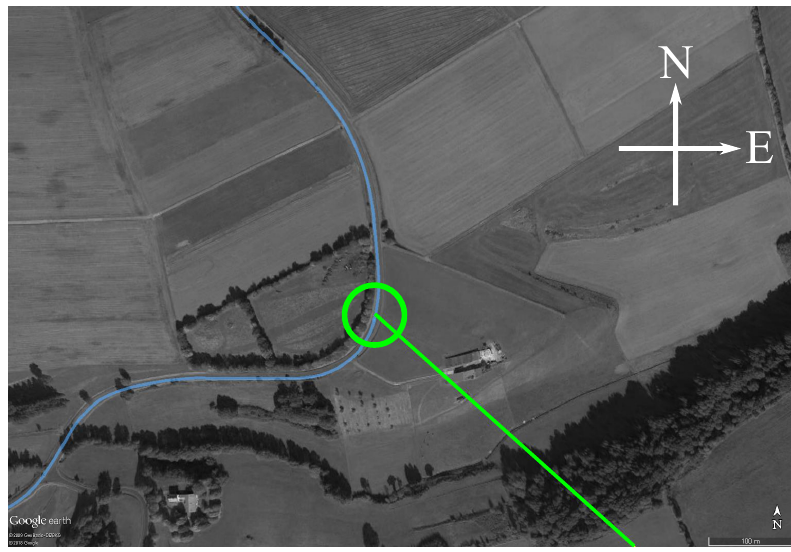
Figure 8. Picture of the trial site. The blue line indicates the trajectory of the receiver, while the green circle indicates its position at the time stamp of data evaluation. The green line indicates the baseline. Map data: ©Google, ©GeoBasis-DE/BKG